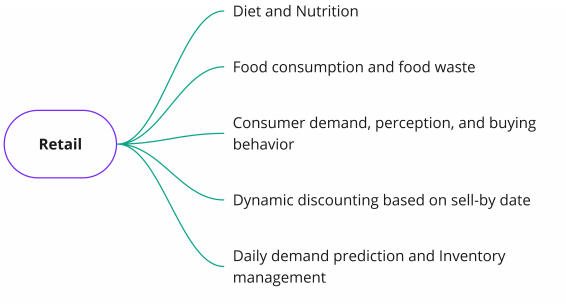
Figure 9. FSC problems in the retail